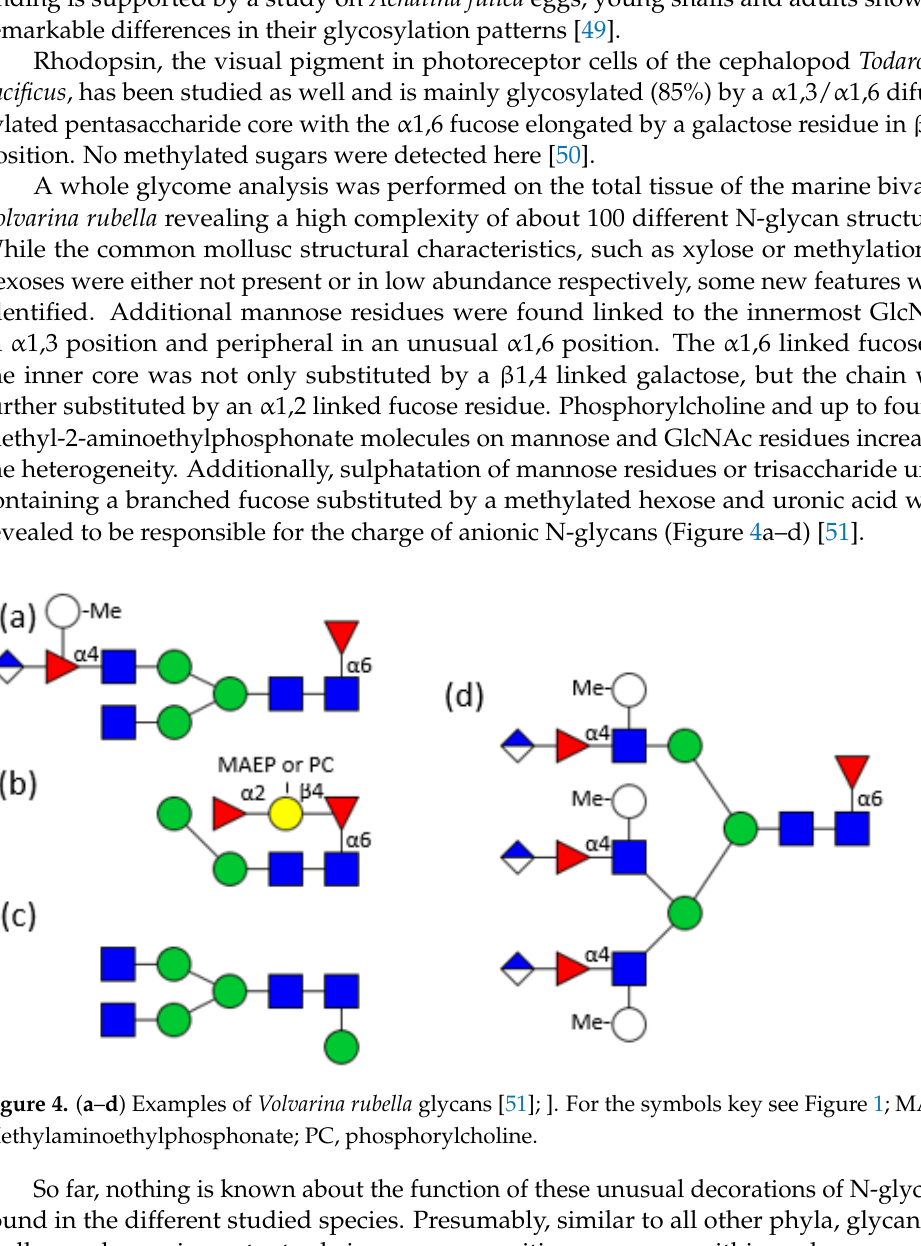
Figure 4. ( a – d ) Examples of Volvarina rubella glycans [51]; ]. For the symbols key see Figure 1; MAEP, Methylaminoethylphosphonate; PC,